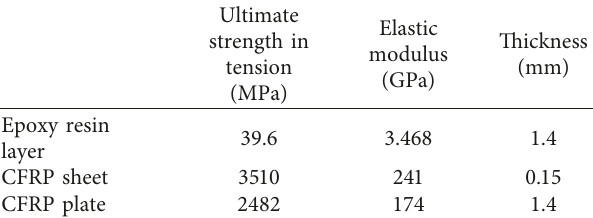
Table 3: Adhesive and CFRP